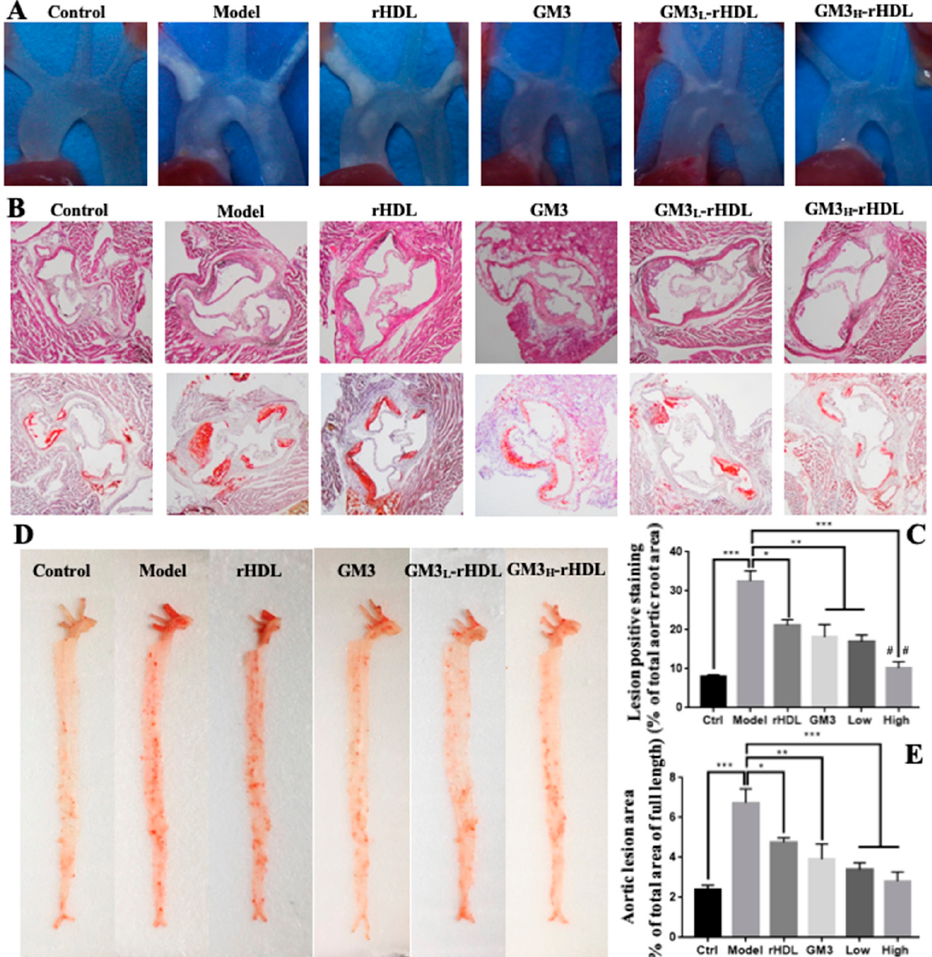
Figure 5. Inhibitory effects of GM3-rHDL nanoparticles on the high fat diet-induced increases in concentrations of main blood lipids in ApoE − / − mice. The mice were fed a chow diet (ctrl) for eight weeks or a high-fat diet in combination with no treatments (model) or with a treatment (once every three days) of rHDL, ganglioside GM3 (1.2 mg/kg), GM3 L -rHDL nanoparticles (0.2 mg/kg GM3), or GM3 H -rHDL nanoparticles (1.2 mg/kg GM3), respectively for eight weeks. ( A ) Triglyceride (TG). ( B ) red fluorescence was observed on the fragments incubated with Nile Red-stained rHDL Total cholesterol (TC). ( C ) LDL-cholesterol (LDL-C). ( D ) HDL-cholesterol (HDL-C). * p < 0.05, ** p < (Figure 8B) or GM3-rHDL (Figure 8C) nanoparticles but not on the fragment incubated 0.01, *** p < 0.001 ( n = 6) compared with the control or with the model; # p < 0.05, ## p < 0.01 ( n = 6) with Nile Red-treated NLC nanoparticles (Figure 8D). The data implies that both rHDL compared with the GM3 group. and GM3-rHDL nanoparticles have the atherosclerotic plaque-targeting ability.